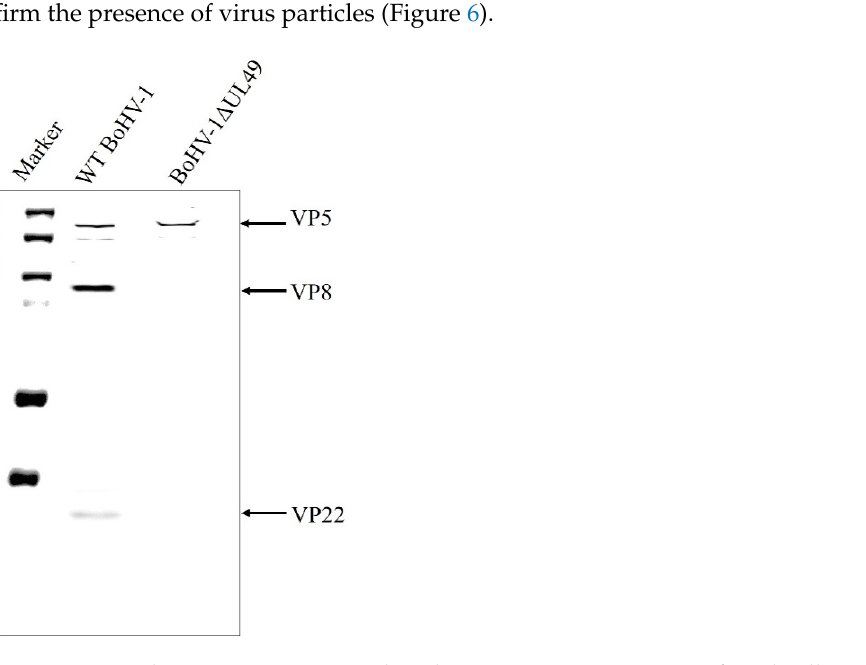
Figure 6. VP8 is absent in primary enveloped virus in BoHV-1 ∆ UL49-infected cells. Primary enveloped virus was purified from the NMP of MDBK cells infected with BoHV-1 ∆ UL49 at an MOI of 3, and harvested 18 h post-infection. The proteins in the primary enveloped virus were separated by SDS-PAGE on 8% gels, and VP8 and VP22 were identified by Western blotting with mouse VP8-specific monoclonal antibody and rabbit VP22-specific polyclonal antibody, followed by IRDye 680RD goat anti-mouse IgG and IRDye 800RD goat anti-rabbit IgG, respectively. The positions of the tegument proteins VP8 and VP22 are indicated with arrows. Molecular weight markers (MWs) × 10 − 3 are shown in the left